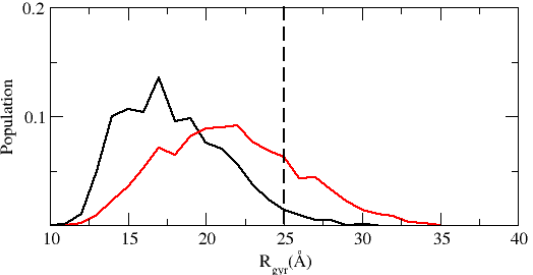
Figure 7. Distribution of radii of gyration in the simulations of the disordered protein ACTR in explicit solvent MD simulations with TIP4P/2005 water (black line) and with the PACSAB model (red line), using the same parametrization used in the simulations of ubiquitin dimerization. The vertical dashed line marks the experimental estimation of the radius of gyration of